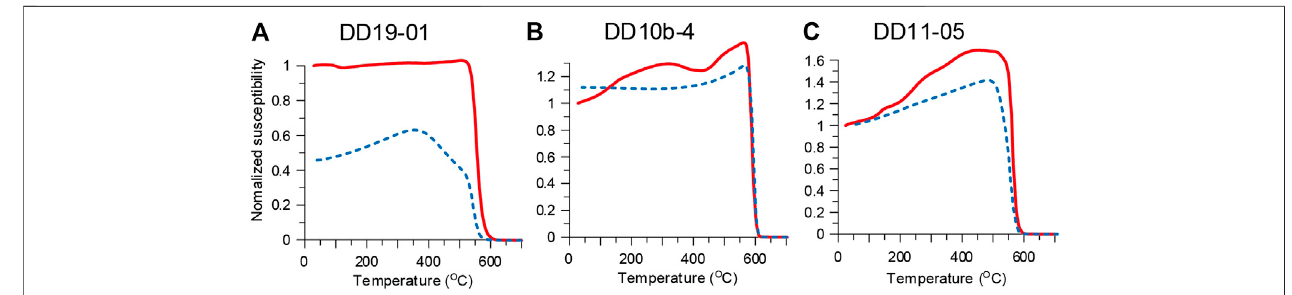
FIGURE 4 | Representative temperature dependent magnetic susceptibility for samples from unit III (A) and unit IV (B , C) . Bold/dashed lines indicate the heating/ cooling curves.